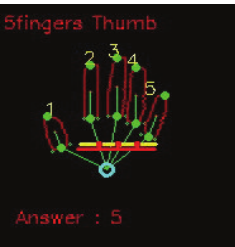
Figure 12: The recognition of the